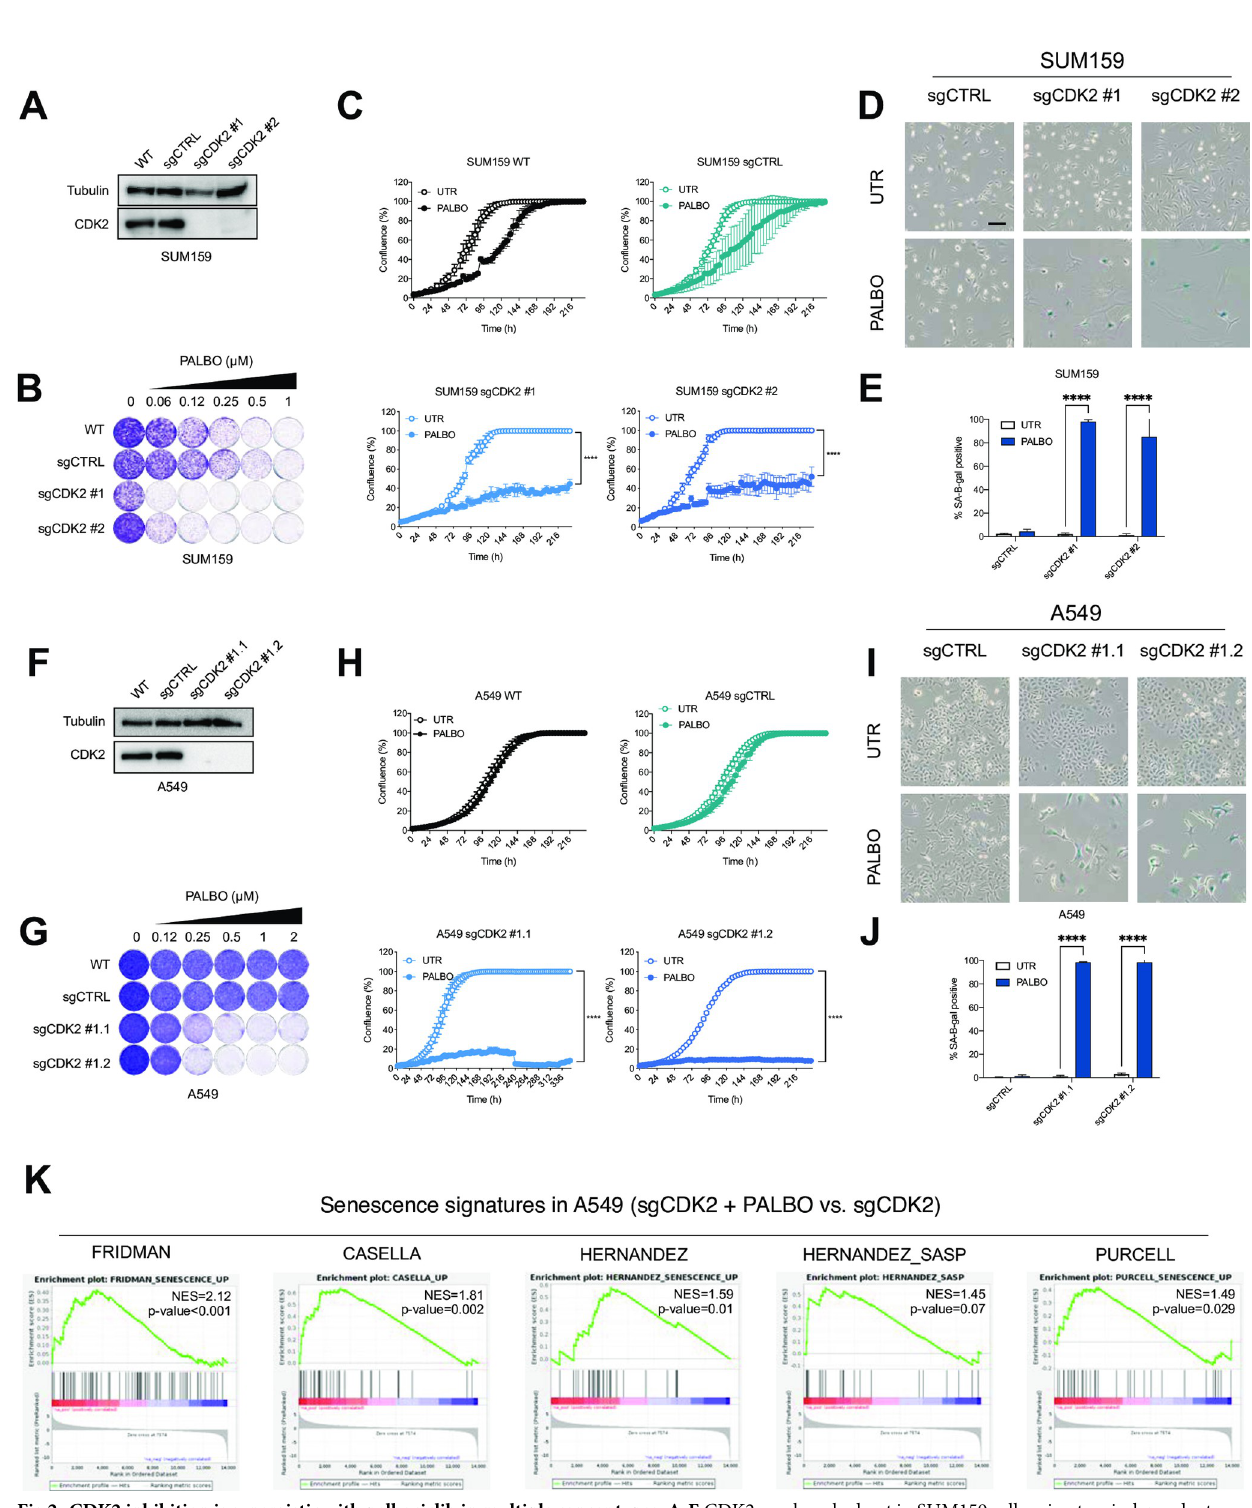
Fig 2. CDK2 inhibition is synergistic with palbociclib in multiple cancer types. A-E CDK2 was knocked out in SUM159 cells using two independent sgRNAs. A Western blot analysis of SUM159 sgCDK2 cells and control cells. Tubulin was used as a loading control. Representative images of two independent experiments are shown (n = 2). B Long term colony formation assay of SUM159 sgCDK2 and control cells with palbociclib was performed for 8 days. Representative of two independent experiments are shown (n = 2). C Proliferation assay of SUM159 sgCDK2 and control cells treated with 0.25 μ M of palbociclib. Mean of three technical replicates representative of two independent experiments (n = 2) is shown and error bars indicate standard deviation.